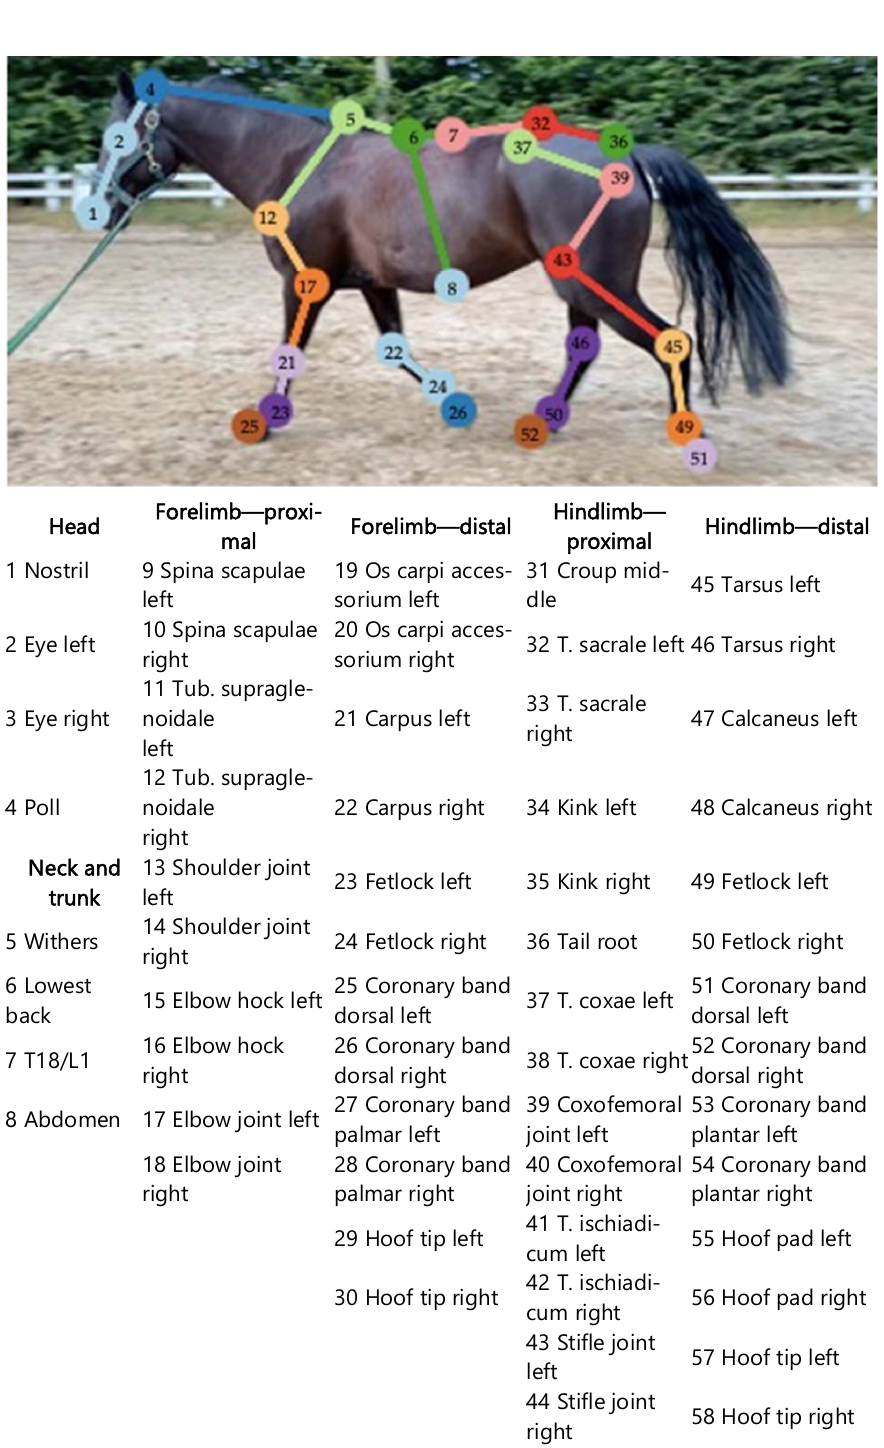
Figure 1. Reference points. Different combinations of reference points can be chosen in the program and offer multiple variations for gait analysis; the picture only shows a selection of the reference points which are enlarged in the image for better visibility. In the program, one reference point corresponds to one pixel. The accurate anatomical locations corresponding to the reference points of the program are listed in Table